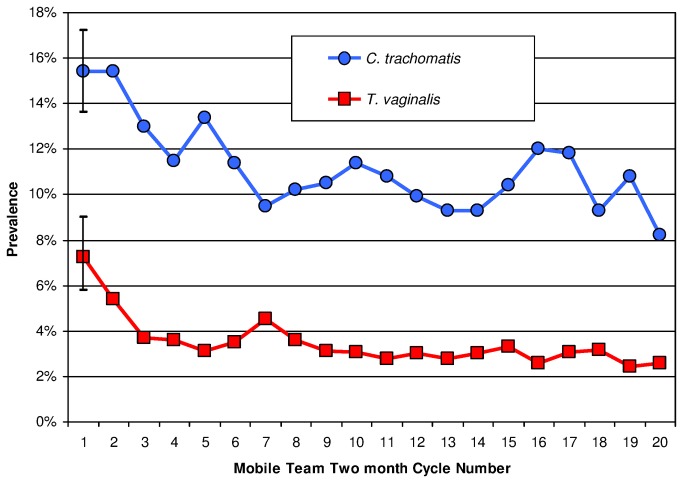
Prevalences of C. trachomatis and T. vaginalis infections among female sex workers.The 95% confidence intervals are shown for Cycle 1 (when the number of encounters was smallest). Reductions in prevalences are significant for C. trachomatis (p <0·001) and for T. vaginalis (p <0·001).